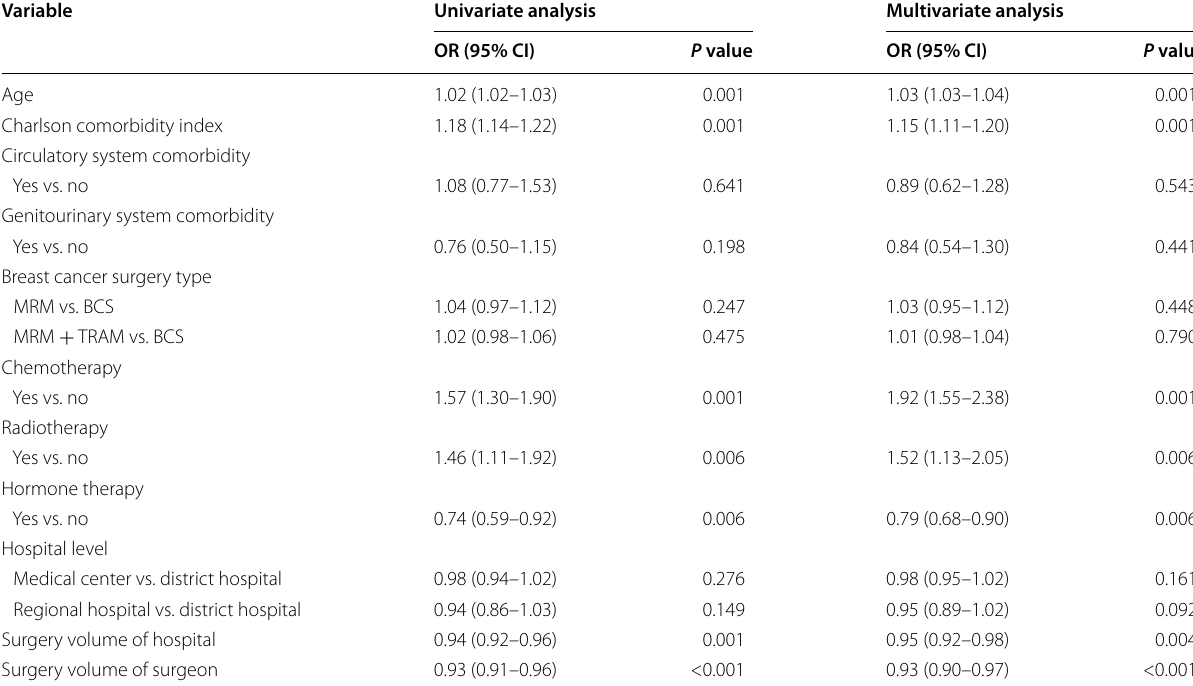
Table 2 The analysis of the relationship between effective predictors and 5-year mortality of the 2543 breast cancer patients using the multiple logistic regression (MLR) model